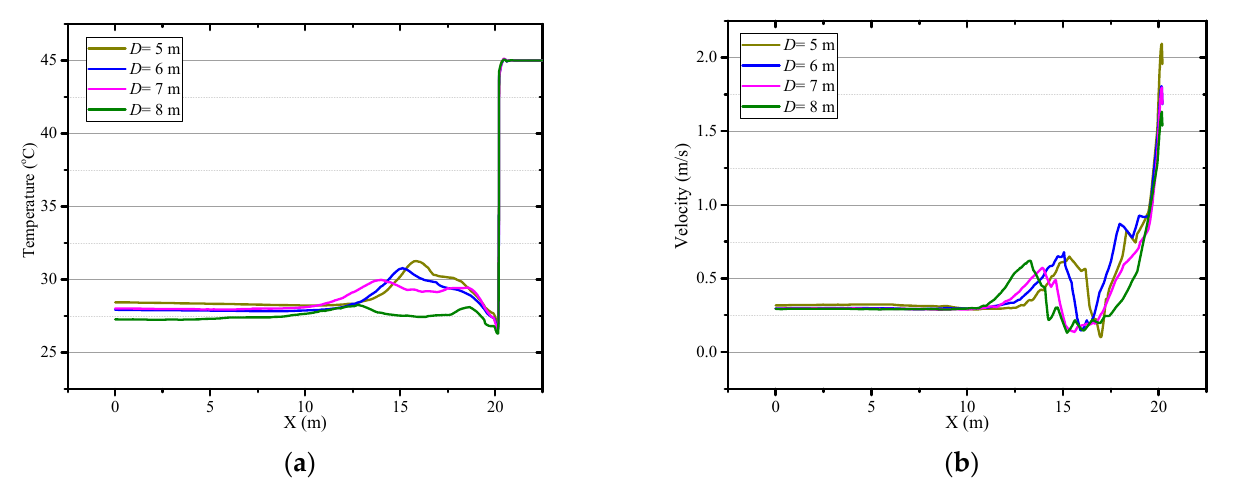
Figure 13. Airflow velocity ( a ) and temperature ( b ) in central axis of roadway (Z = 0.5 m) under different distance be-tween duct outlet and working face.